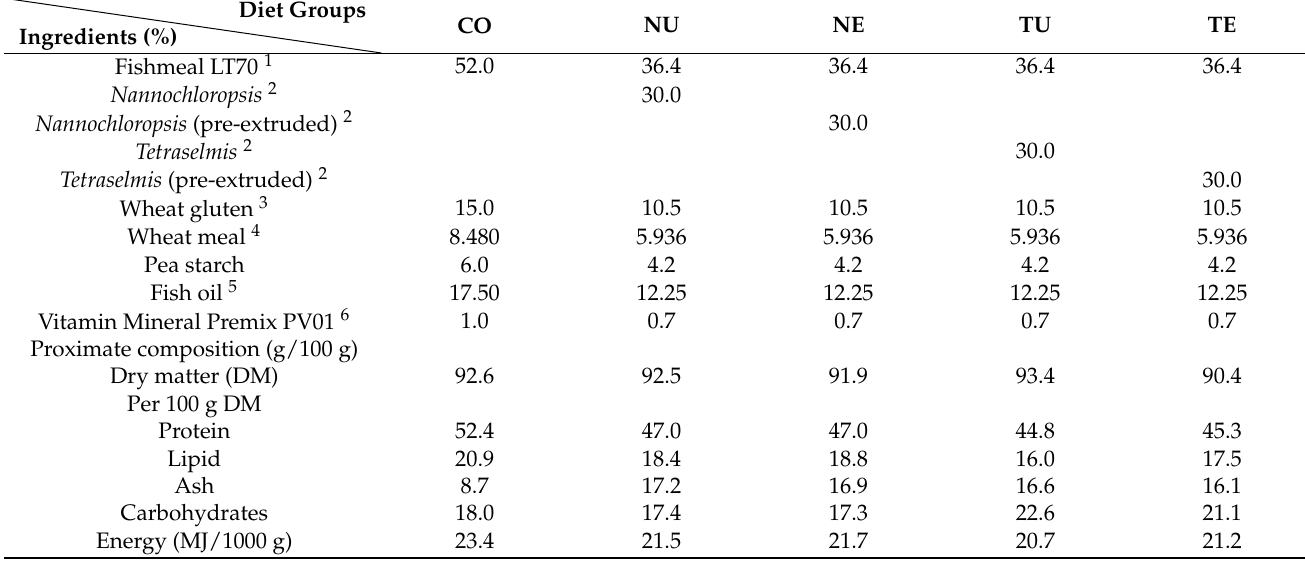
Table 5. Ingredient composition, analyzed chemical composition and energy of the experimental diets. CO NU NE TU TE Ingredients